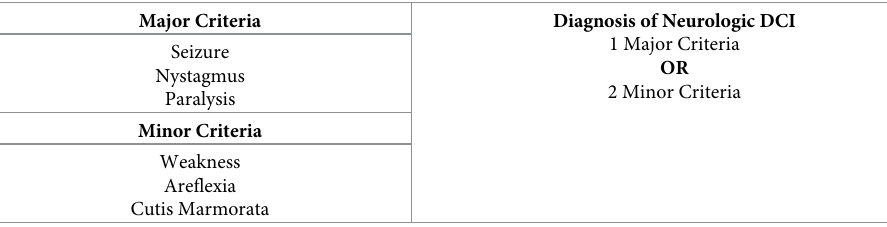
Table 1. Shows the diagnostic criteria used to diagnose neurologic